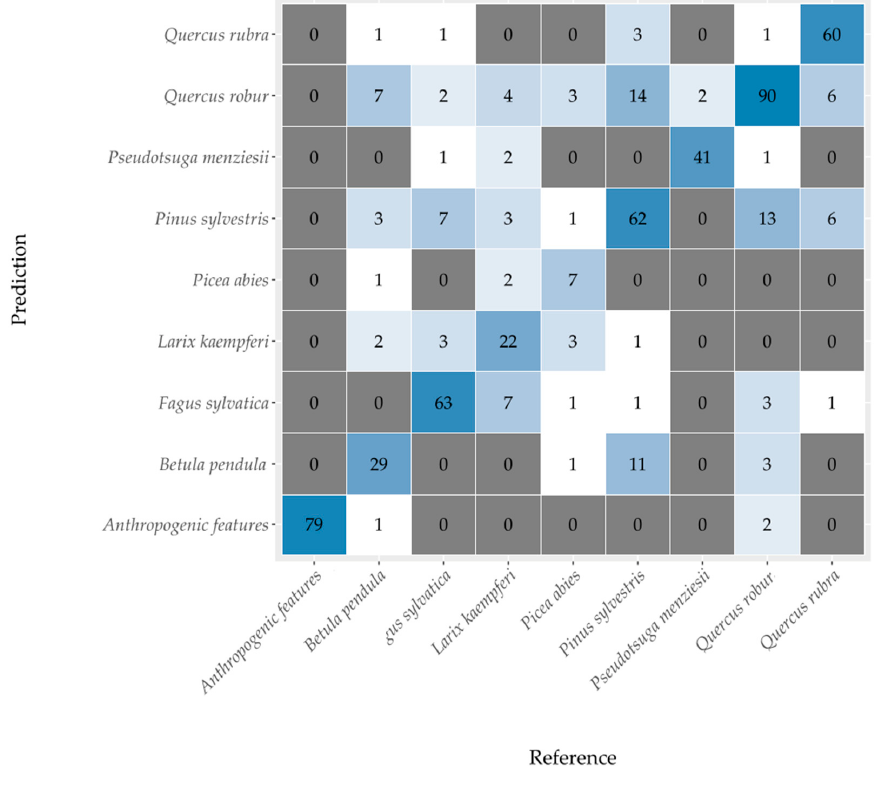
Figure 4. Confusion matrix of the random forest performed on all variables on tree species level (accuracy 78.5% and Kappa value 0.75). Anthropogenic features were also included in the evaluation. The variable importance plot (Figure 5) indicates that the important variable was the red (B04) band from the spring image, followed by the red (B04) band from the winter period. The variable height range had the highest MDG value.